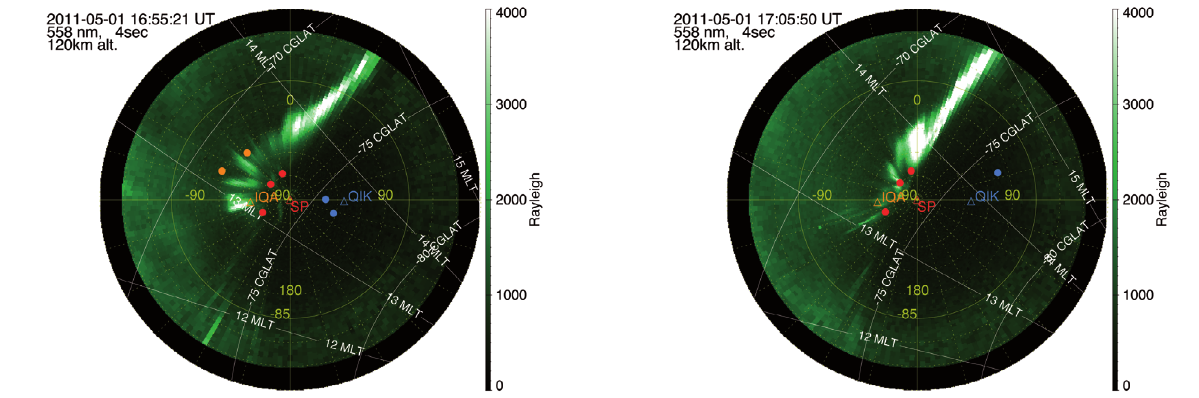
Figure 8. Mapped 557.7-nm images showing a poleward moving auroral form on May 1, 2011.